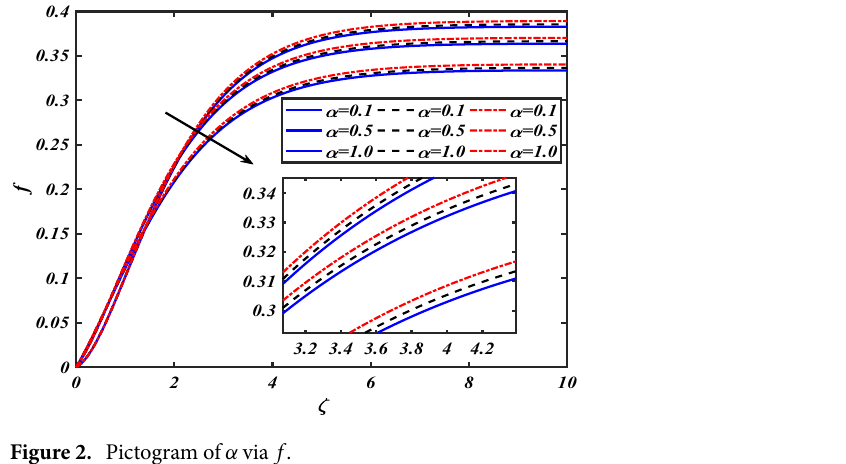
Figure 2. Pictogram of α via f